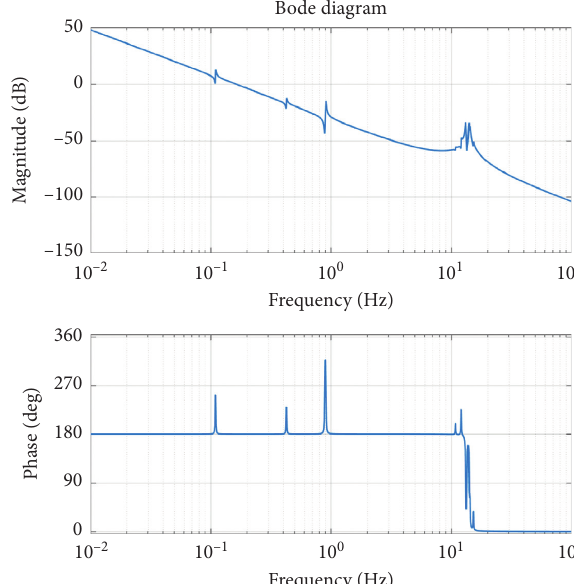
Figure 3: Bode magnitude plot of the loop transfer function of the Hubble Space Telescope without the controller.